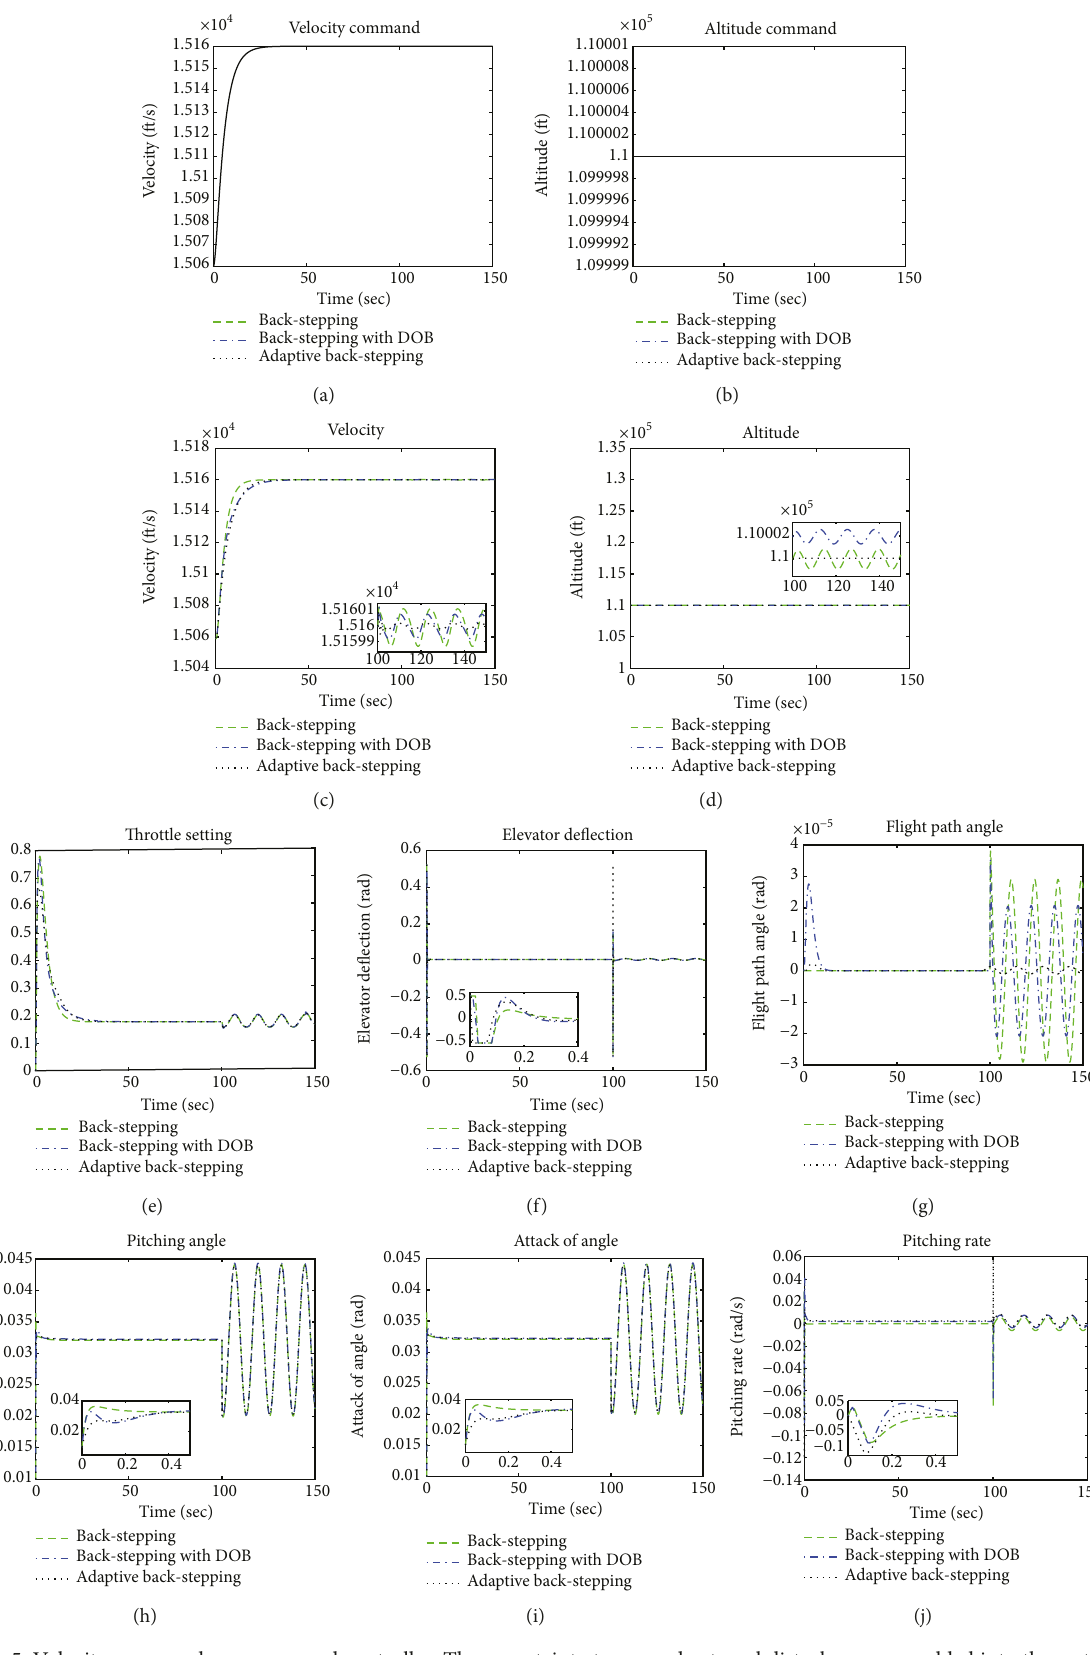
Figure 5: Velocity command, response, and controller. The uncertainty terms and external disturbances are added into the